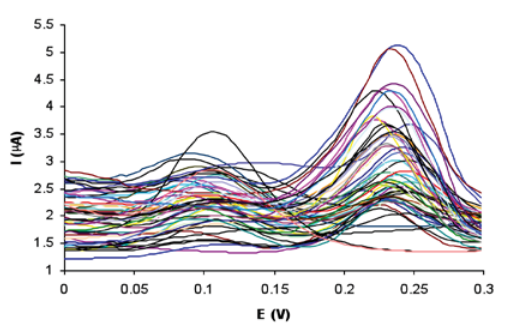
Figure 6. Differential pulse voltmmogrms of mixtures of AA, UA and DA used as calibration set for PLS modeling, step potential = 2.5 mV.